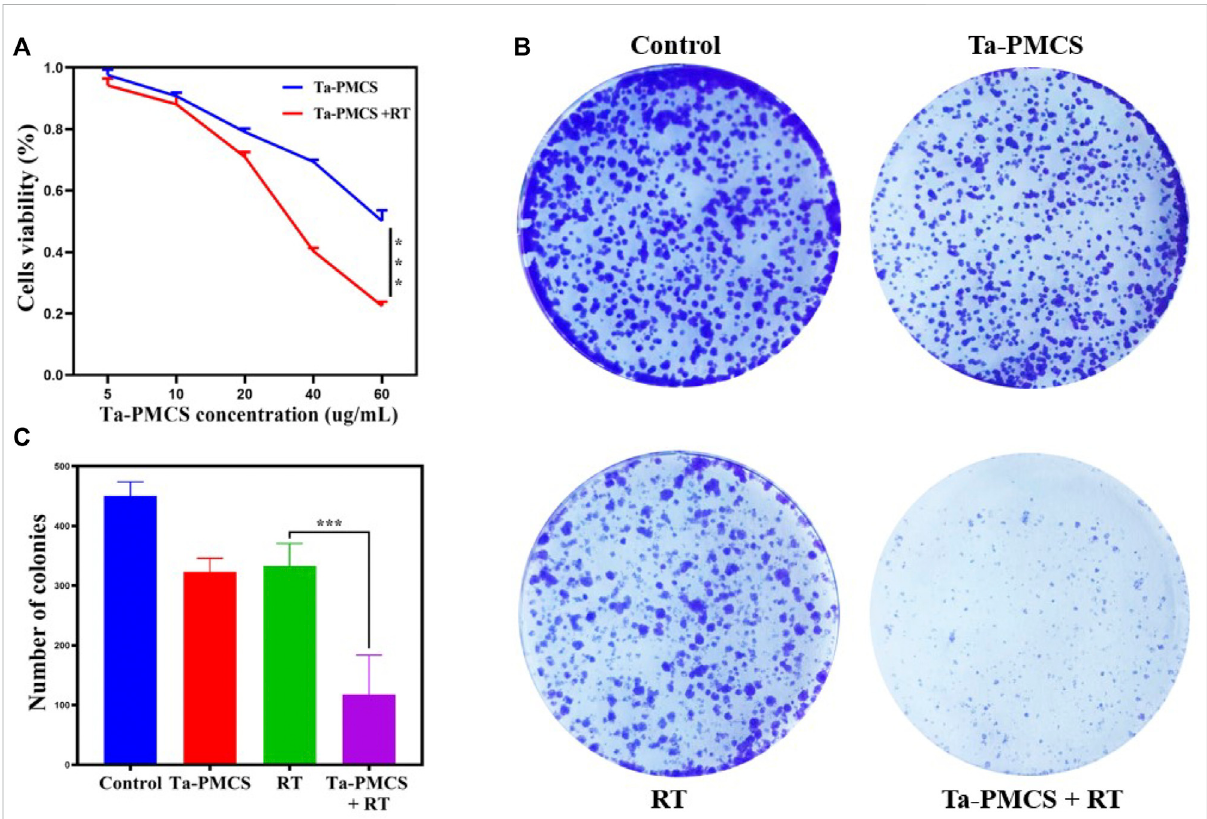
Assessment of theanti-proliferation ability of Ta-PMCS in vitro . (A) CCK-8 assay of HeLacells treat with Ta-PMCS or Ta-PMCS + RT atdifferent concentration gradients. (B,C) Colony formation assays were used to detect the proliferation of HeLa cells treated with the control, Ta-PMCS, RT